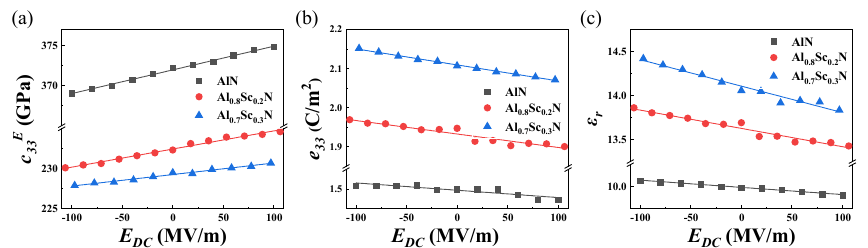
Figure 5. The extracted values of equivalent piezoelectric parameters with different E DC . ( a ) Stiffness coefficient c 33 ; ( b ) Piezoelectric coefficient e 33 ; ( c ) Relative dielectric constant ε r .